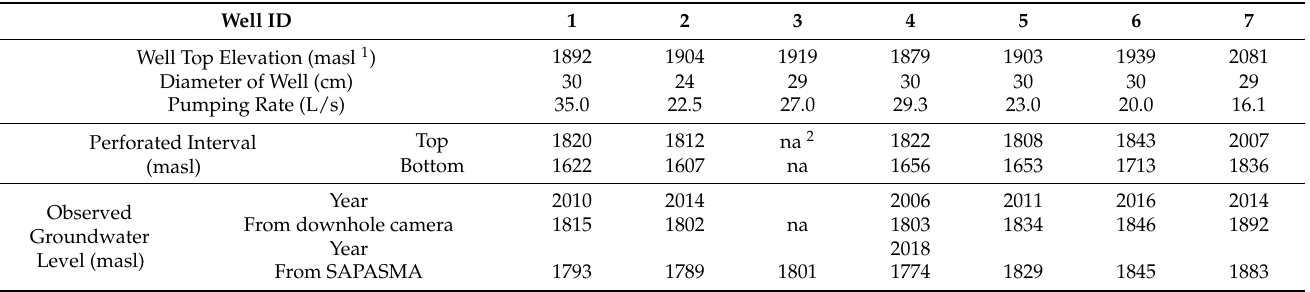
Table 1. Well construction, static water level and pumping rates for the 7 municipal production wells of